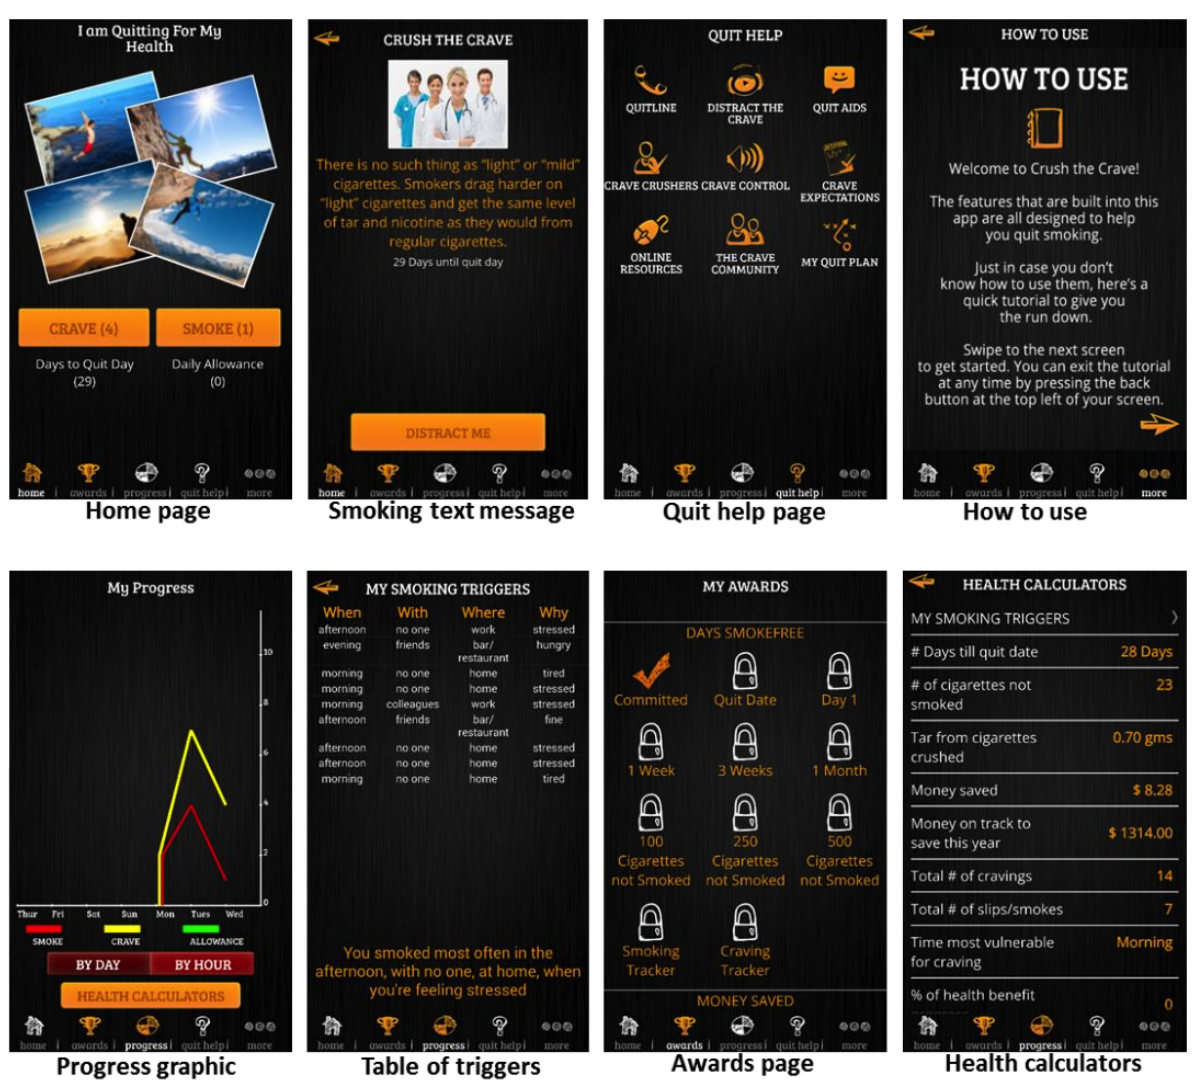
Figure 3. Sample screenshots of Crush the Crave